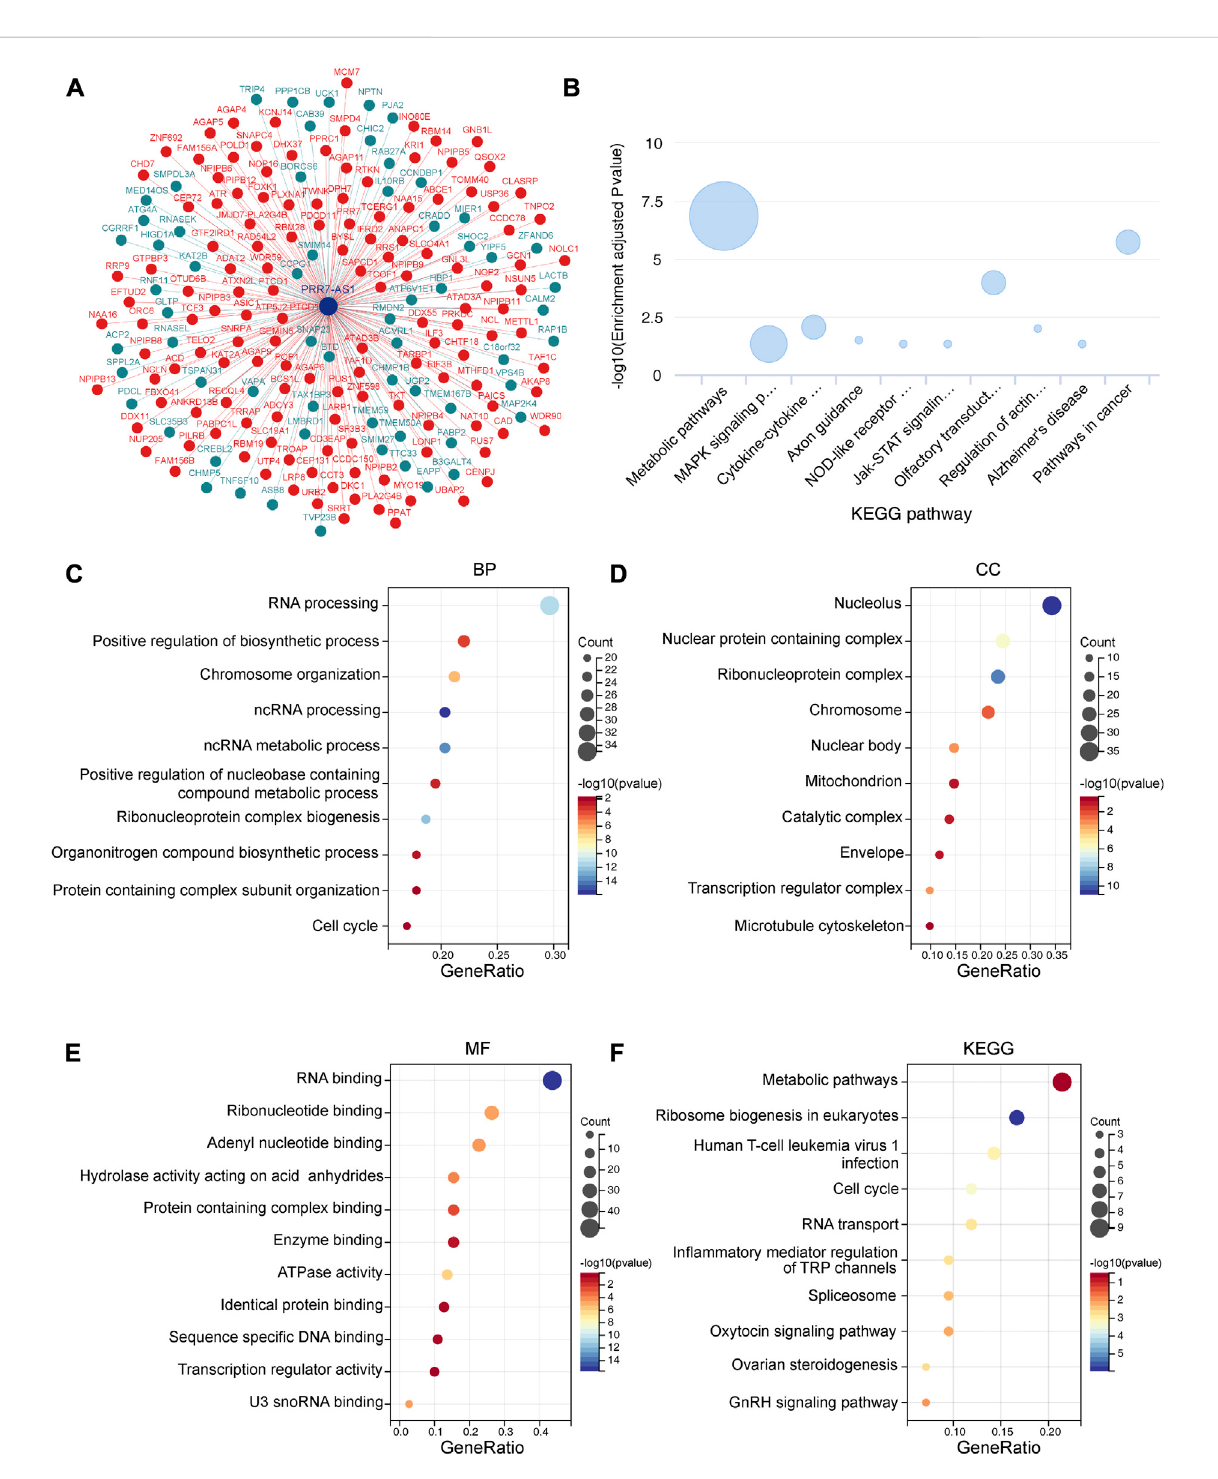
FIGURE 9 Functional enrichment analysis of PRR7-AS1. (A) The co-expression interaction network of PRR7-AS1 from lnCAR database. (B) The KEGG pathway analysis of PRR7-AS1 by lnCAR database (CR_S36). (C – F) GO and KEGG analysis for PRR7-AS1 associated genes. (BP, Biological process; CC, Cellular component; MF, Molecular function; KEGG, kyoto encyclopedia of genes and